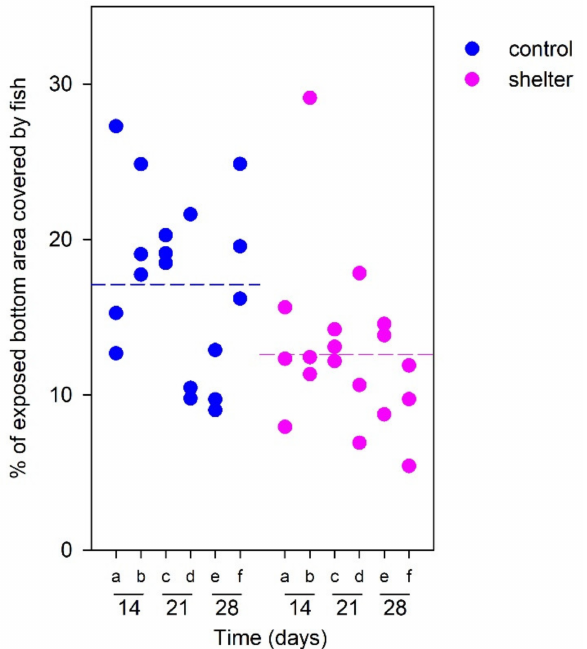
Figure 6. Spatial distribution of rainbow trout ( Oncorhynchus mykiss ) fingerlings in tanks with and without immersed cover. Data represent quantification of placement (percentage of exposed tank bottom area covered by fish in zenithal pictures), obtained in six different occasions: Events “a” to “f” correspond to zenithal pictures obtained in the morning or afternoon of a day during day 14 (a, b), day 21 (c, d), and day 28 (e, f) of the experimental period. High values indicate high presence of fish in the exposed (not-sheltered) part of the tank. Dotted lines indicate the mean values for both treatment groups. A significant effect of cover was found ( p = 0.038, two-way repeated measures ANOVA), where exposed fish in tanks with cover were less densely distributed compared to fish in open tanks. No temporal effects were found after comparing sampling events ( p = 0.117) and there was no interaction between both factors ( p =